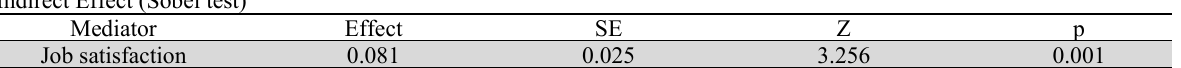
Job satisfaction